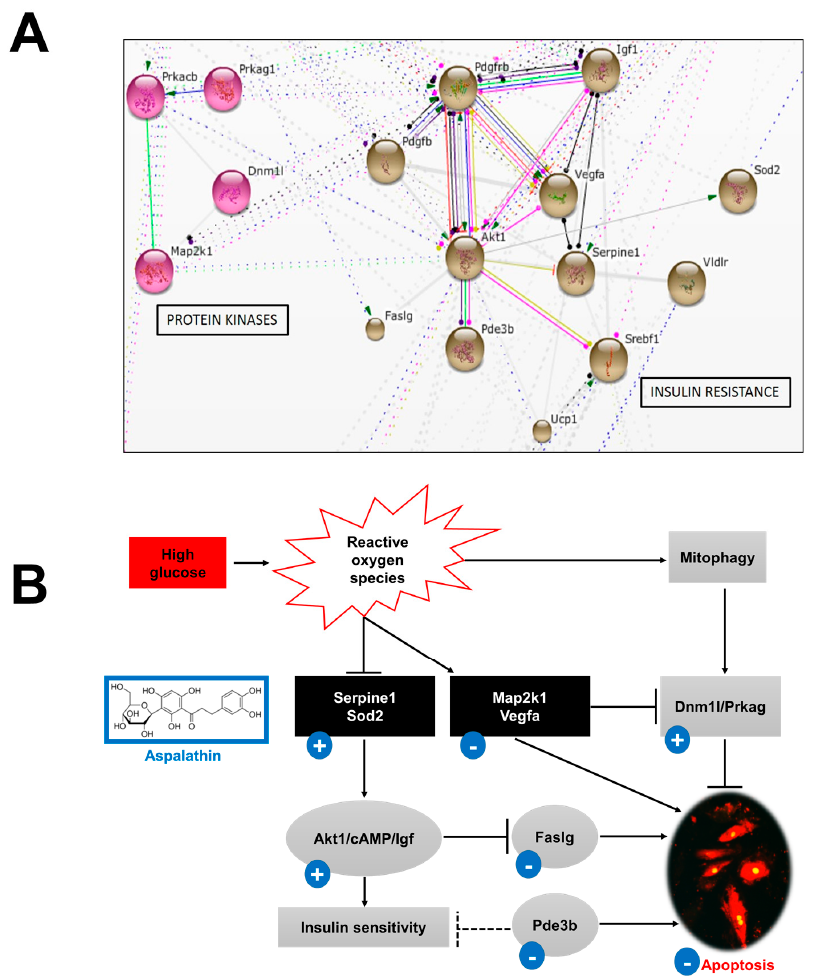
Figure 2. Aspalathin prevented high glucose-induced insulin resistance. ( A ) STRING database analysis confirmed a strong interaction between aspalathin treatment and genes associated with insulin resistance; ( B ) Representative diagram of the proposed protective mechanism of aspalathin